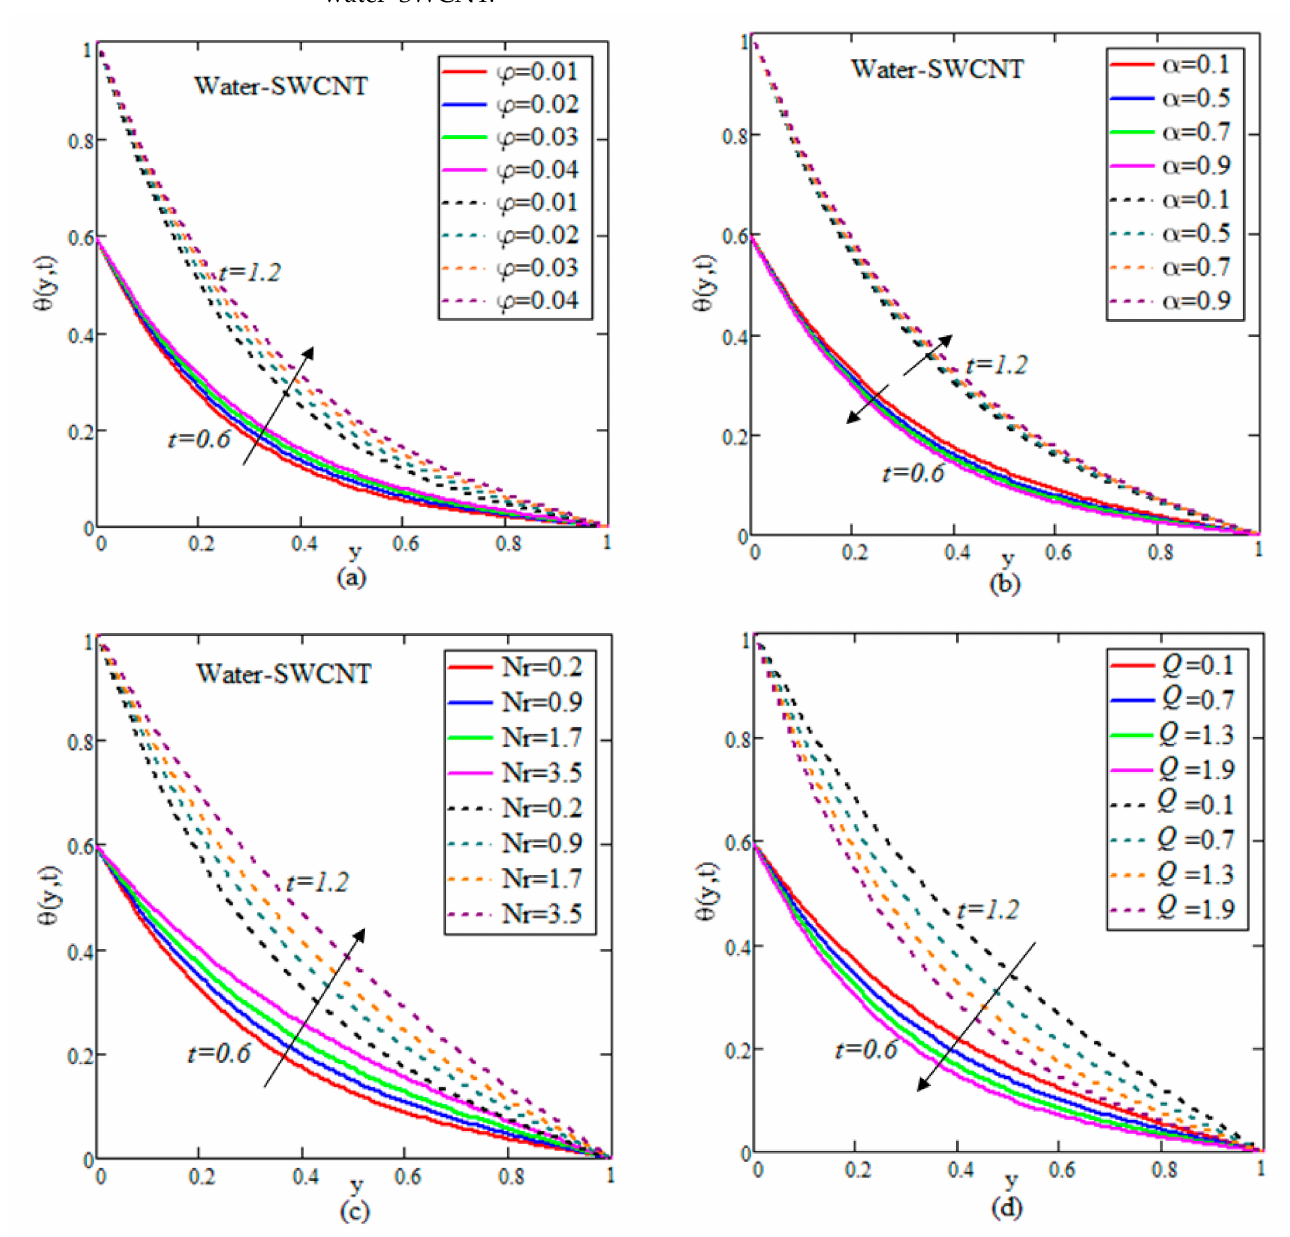
Figure 2. ( a – d ) Deviation of